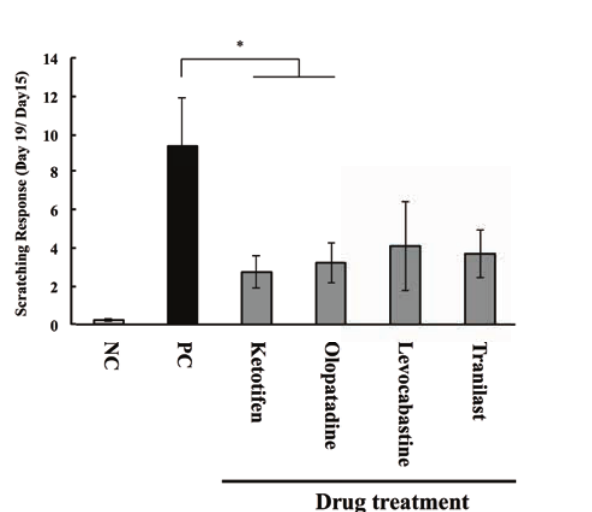
Figure 3: Effects of anti-allergic drugs on the scratching